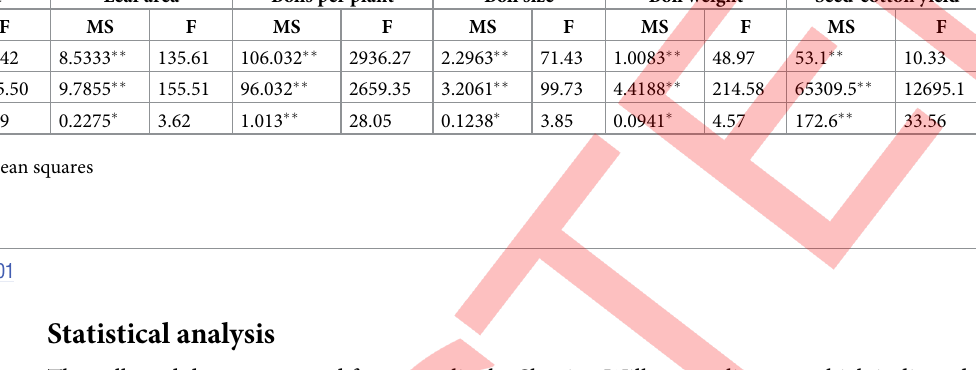
Table 1. Analysis of variance of different soil applied boron doses on plant height, leaf area, number of bolls per plant, boll size and weight, and seed-cotton yield of cotton cultivars. SOV DF Plant height